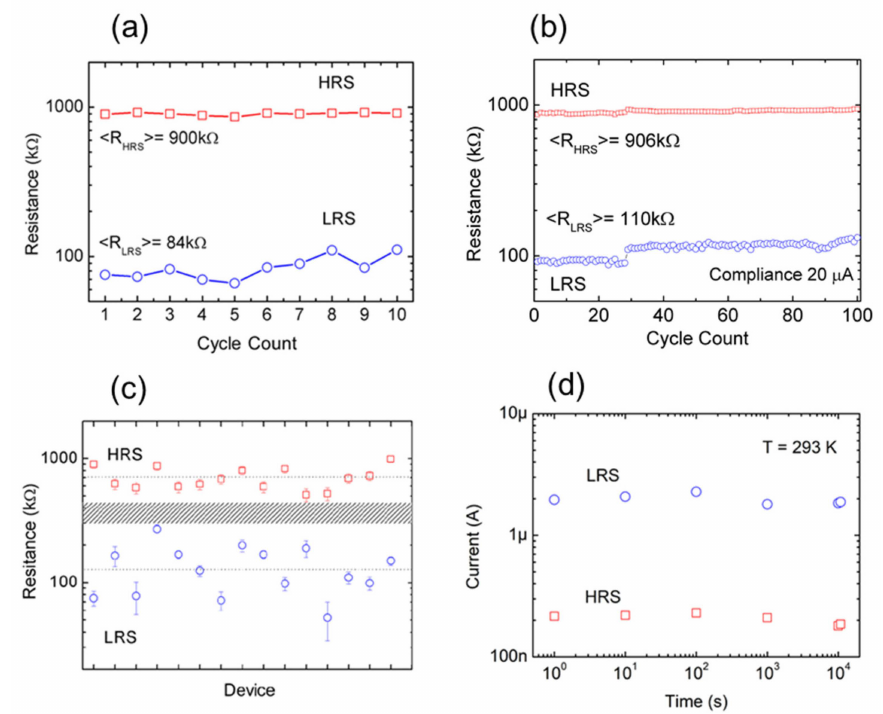
Figure 4. ( a ) Resistance values obtained from successive programming / erasing cycles without current compliance. Average values of the resistance at the HRS and LRS are included. ( b ) Resistance values obtained from successive device cycling demonstrating up to 100 cycles. The experiments were carried out by establishing a current compliance of 20 µ A. ( c ) Resistance values obtained from 15 di ff erent memristors at the HRS and LRS states. Error bars illustrate the resistance variability of the device during 10 cycles. ( d ) Retention characteristic of laser-reduced graphene oxide memristor at room temperature (same device for LRS and HRS states). The state of the device is read with 0.2 V pulses during 50